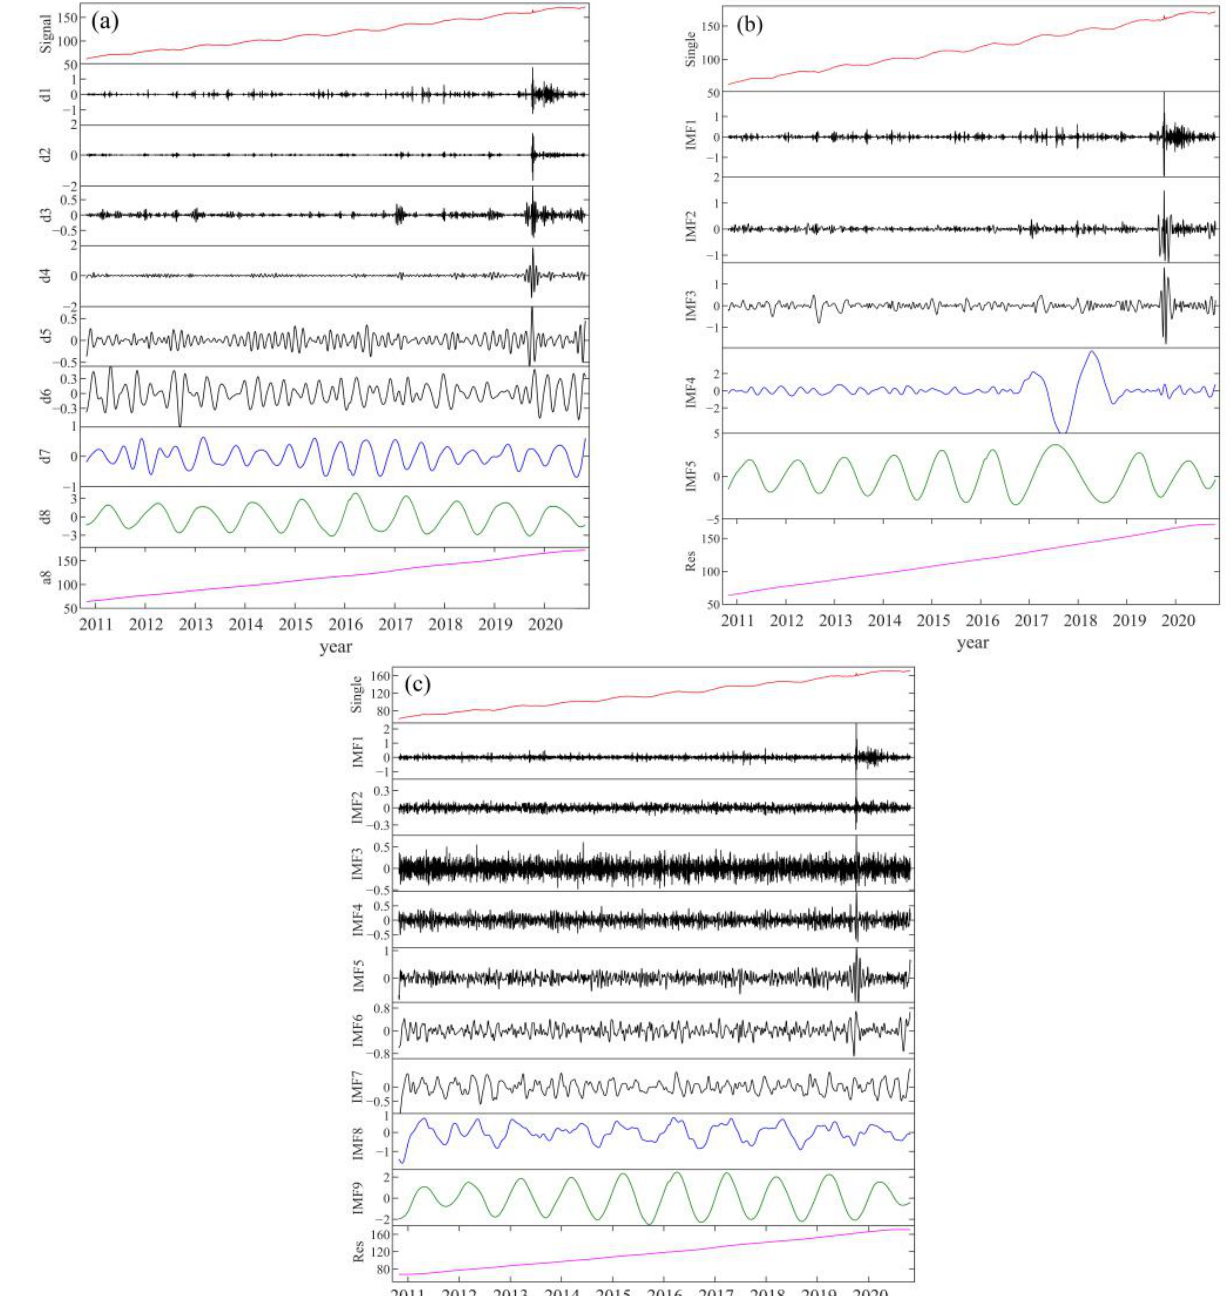
Figure A2. Decomposed results of the denoised GNSS data in N component at the P242 station based on WD ( a ), EMD ( b ), and CEEMD ( c ), respectively.